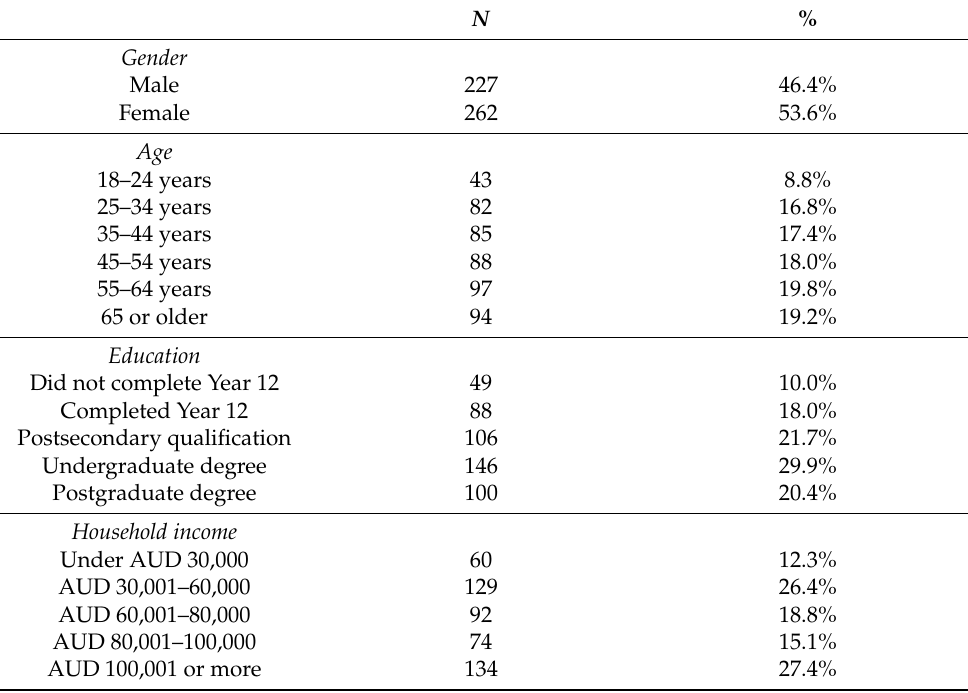
Table 1. Demographic